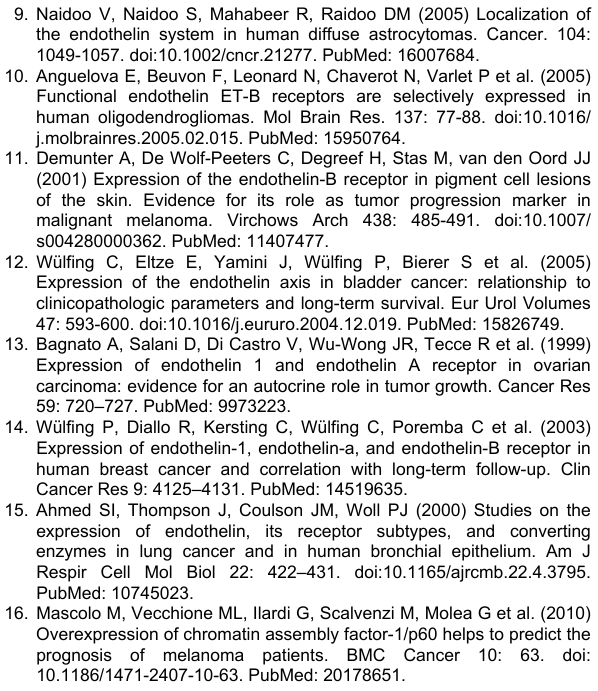
Figure S1. Time-dependent AUC plots and ROC curves used for optimal cut-off selection.